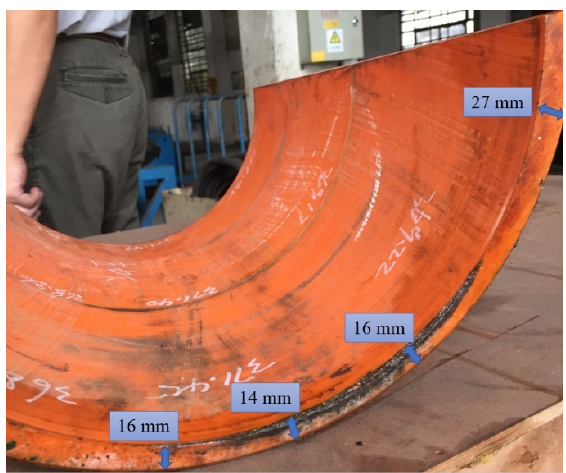
Figure 1. The excessively worn bearing.